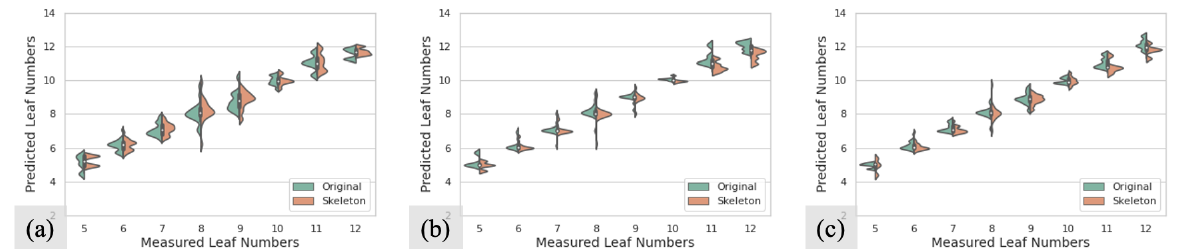
Figure 10. The distributions of predicted leaf numbers in testing datasets with occlusion: ( a ) predic- tion distributions in S2 datasets without augmentation; ( b ) prediction distributions in S2 datasets with six transformations; ( c ) prediction distributions in S2 datasets with twelve transformations. In each plot, green parts represent the results from the original images, and orange parts represent the results from skeleton